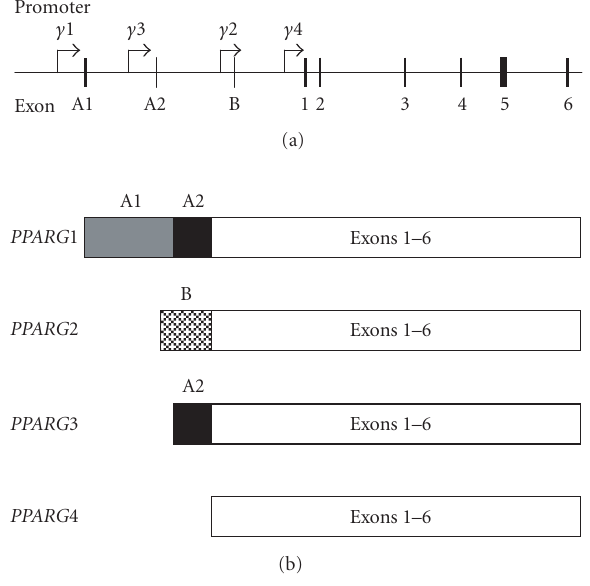
Figure 1: A schematic representation of the PPARG gene. (a) The PPARG gene is composed of nine exons, named A1, A2, B, 1, 2, 3, 4, 5, and 6, respectively, and four promoters. (b) There are four major PPARG transcripts, all of which contain exons 1 through 6. Expression of each transcript is controlled by one of the four pro- moters. All of the transcripts yield the same protein, except for the γ 2 transcript, which codes for 30 additional amino acids on the N-